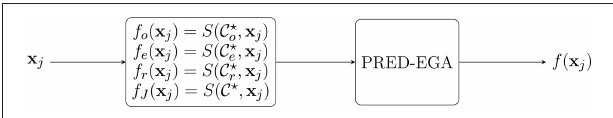
FIGURE 1 | Flowchart diagram: Deep Network for BG prediction.